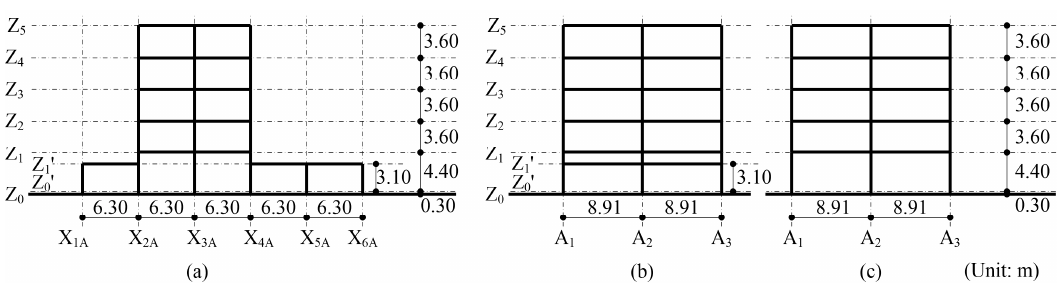
Figure 4. Simplified structural elevation of Uto City Hall: ( a ) frame Y 4 , ( b ) frame B 1 , and ( c ) frame B 2 .